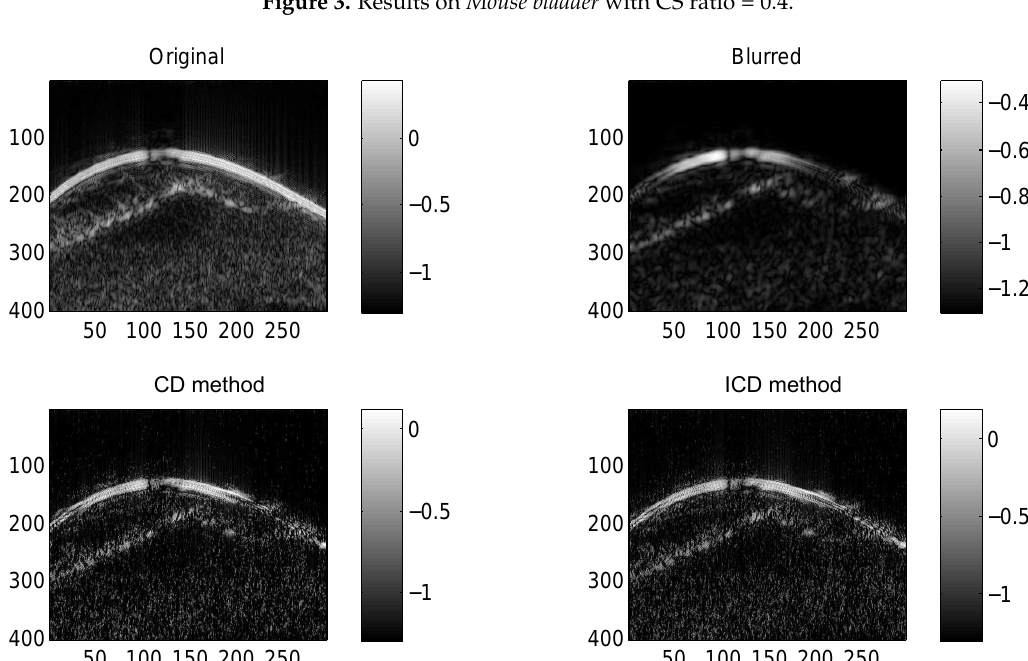
Figure 4. Results on Skin melanoma with CS ratio =